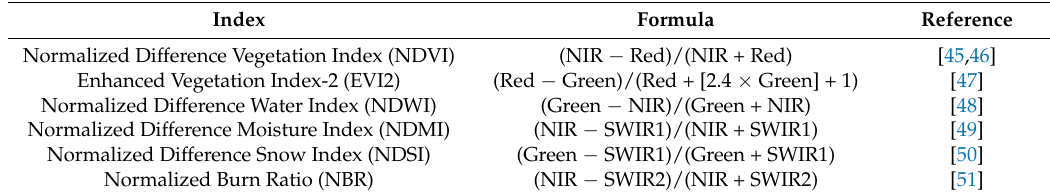
Table 3. Summary of spectral indices used for cover modeling, North Slope,